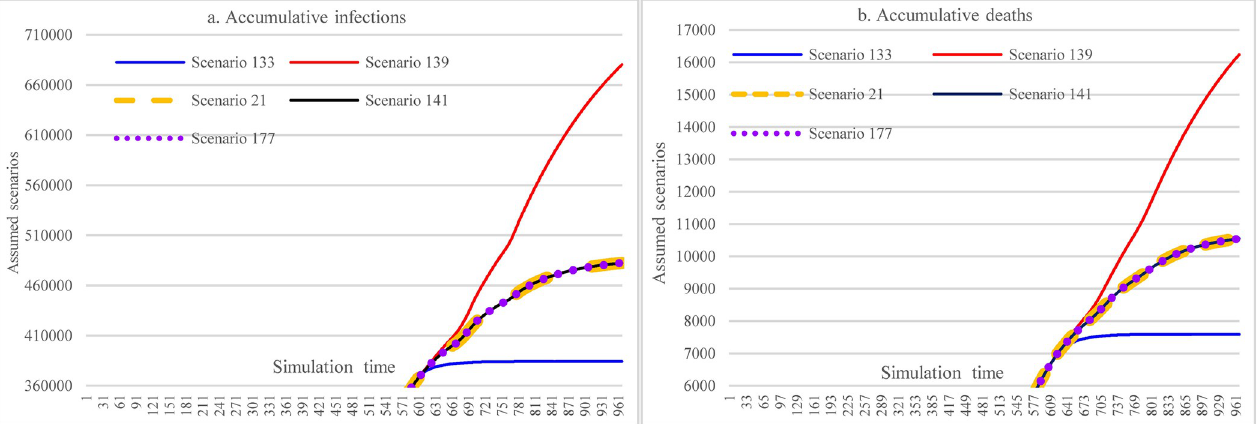
Fig 15. The best-medium-worst outcomes among the defined scenarios.